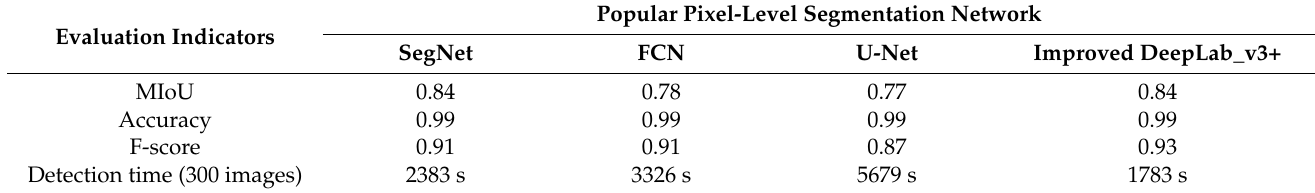
Table 4. Detection results of popular pixel-level segmentation networks.